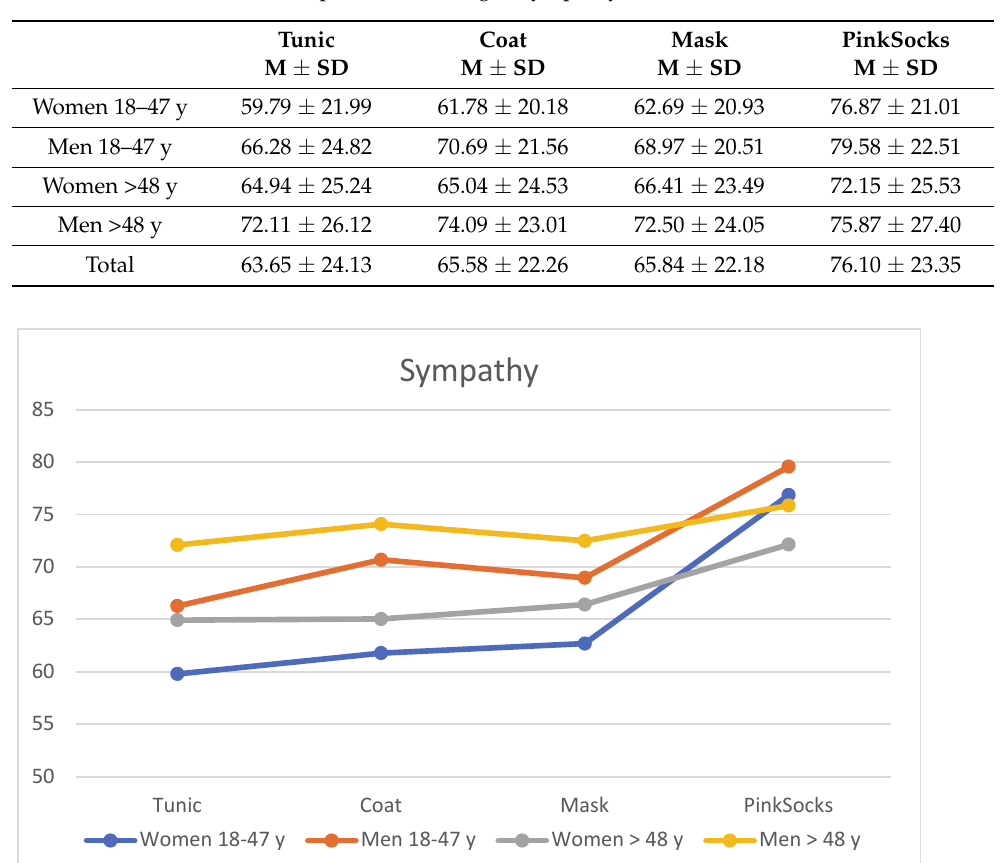
Figure 3. Mean rating of the four photos for likability by the four subgroups ( n = 906).